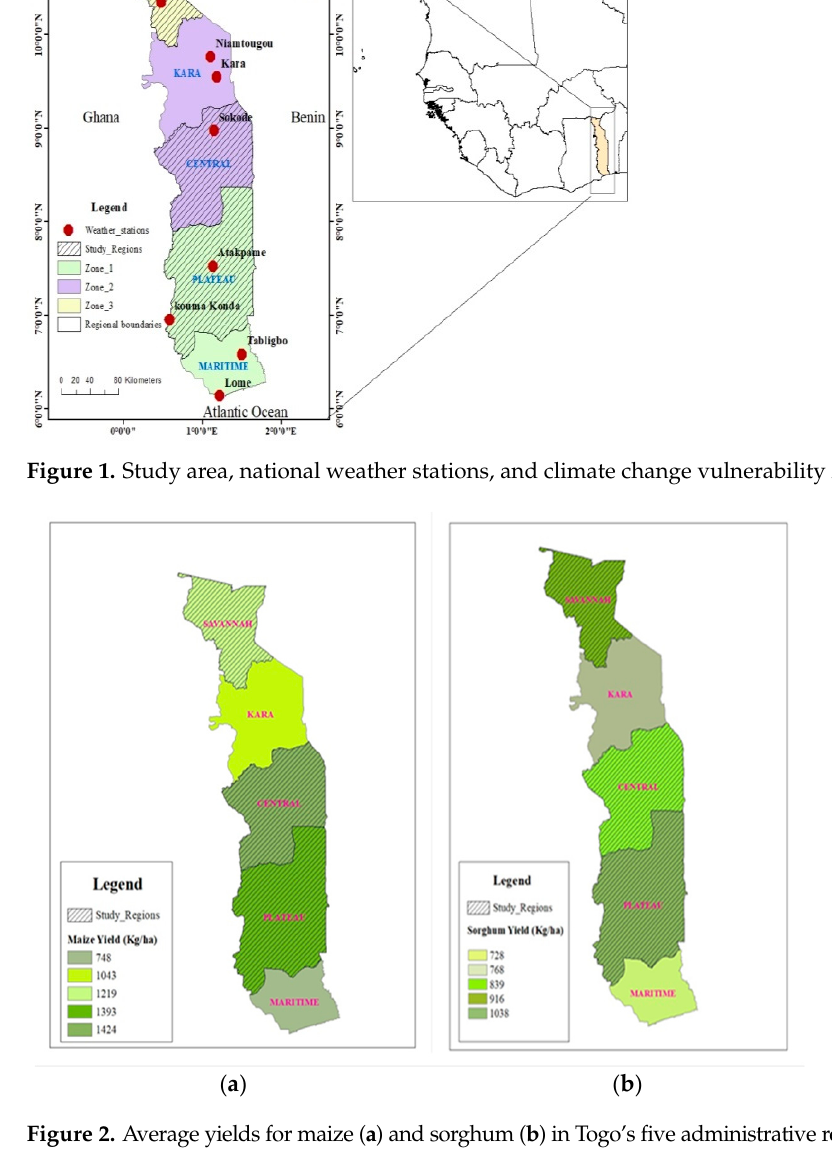
Figure 1. Study area, national weather stations, and climate change vulnerability zones in Togo.